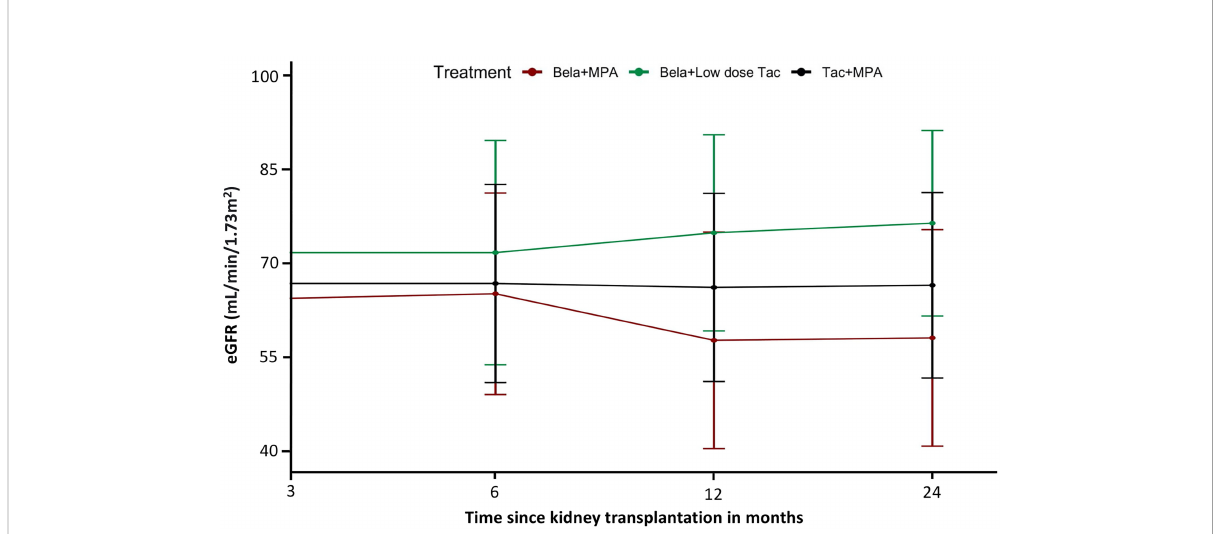
FIGURE 2 Effect of treatment on estimated glomerular fi ltration rate (eGFR): Plots of mean eGFR over time from transplantation indicated improvement of eGFR in Bela+Low dose Tac group during the 24-month period. A linear mixed model showed an estimated positive slope of 8.81 mL per minute per 1.73 m 2 increase in the adjusted eGFR in the Bela+Low dose Tac group and a negative slope of 6.60 mL per minute per 1.73 m 2 in the Bela+MPA group over 24